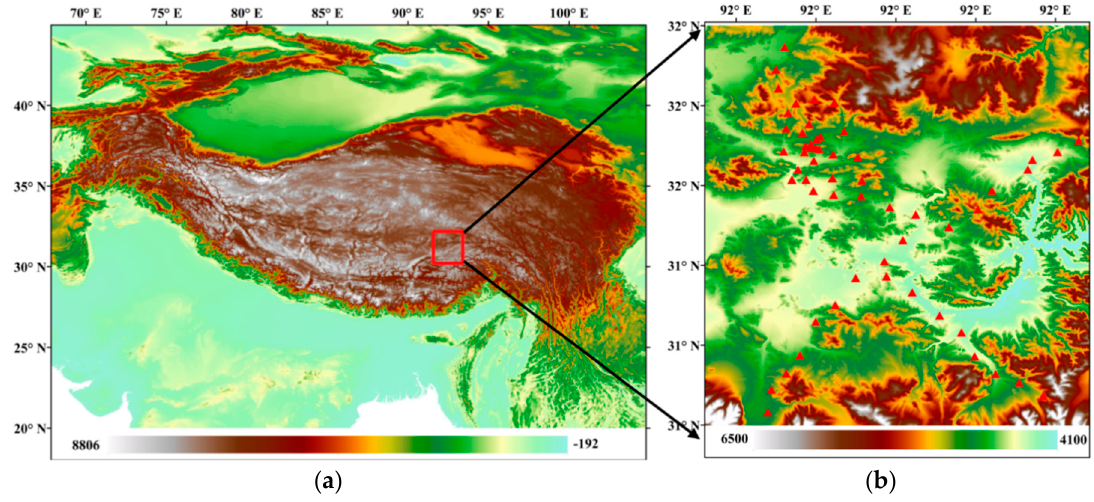
Figure 1. Spatial distribution of the 57 stations in Naqu City, the Tibetan Plateau. ( a ) The location of CPT-SMTMN in the Tibet Plateau; ( b ) The detailed site distribution within CPT-SMTMN. Red triangles present the stations.